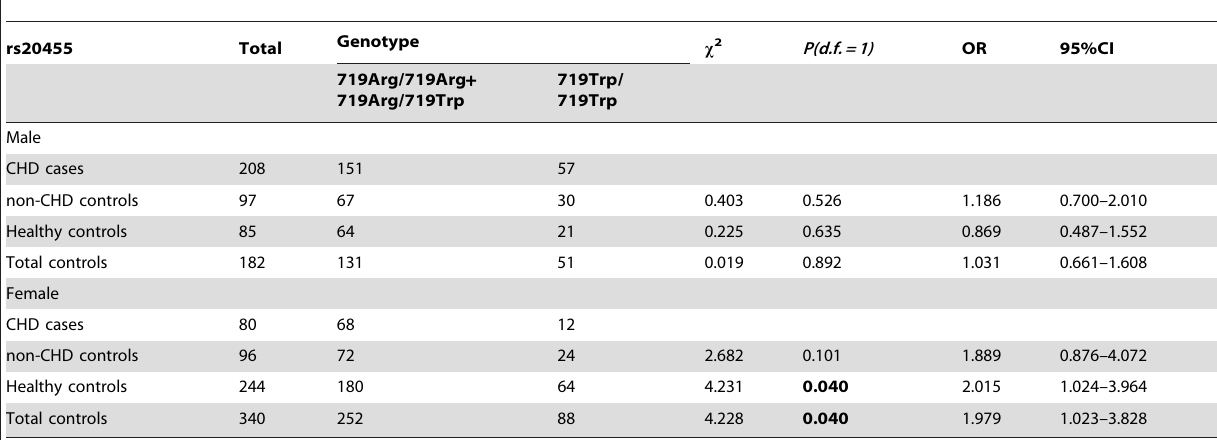
Table 3. The association of Trp719Arg with gender risk in the dominant